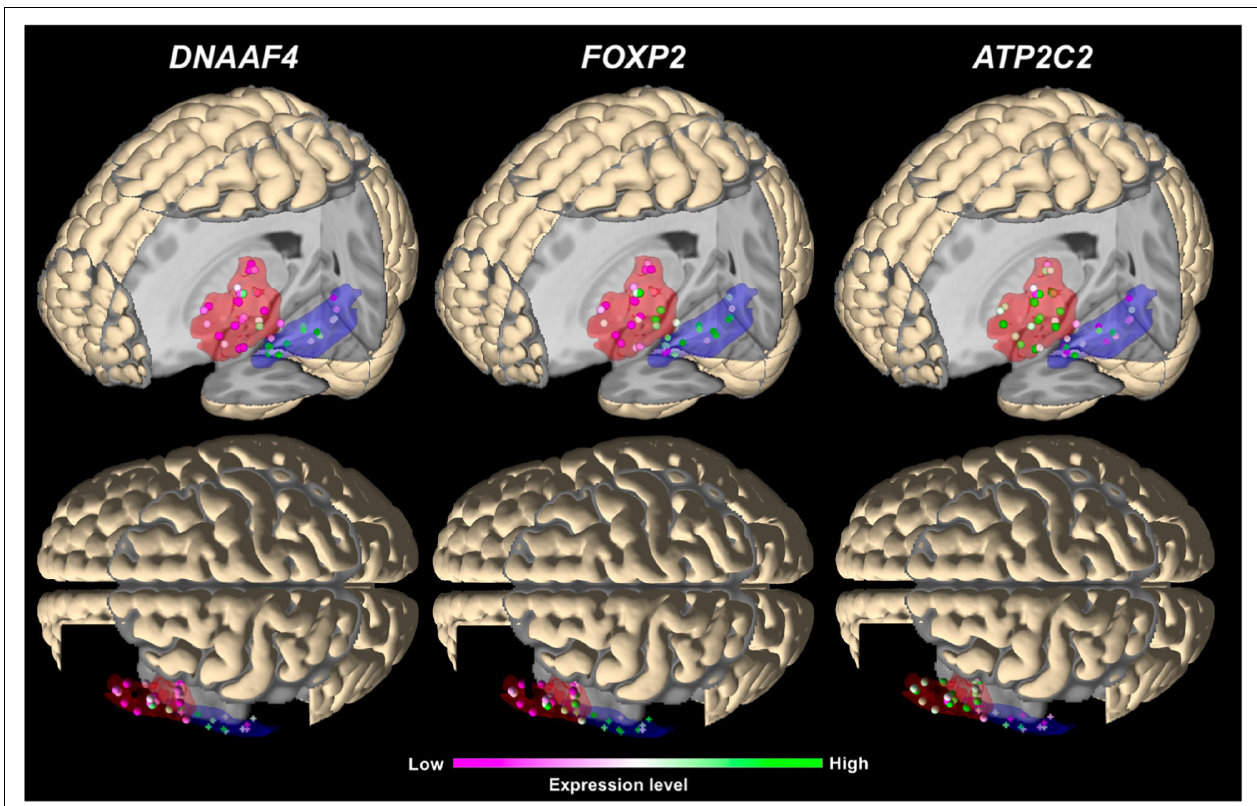
FIGURE 4 | 3D visualization of the main expression analysis using JuGEx in lateral views (top panels) and dorsal views (bottom panels) displaying the three significantly differentially expressed genes: DNAAF4 and FOXP2 show higher expression (FWE-corrected) in Wernicke’s region and ATP2C2 in Broca’s region. Investigated tissue samples are represented by spheres in the red areas (Broca’s region) and crosses in the blue areas (Wernicke’s region). RNA expression levels are indicated by z-scores showing ranges between maximal (green) and minimal values